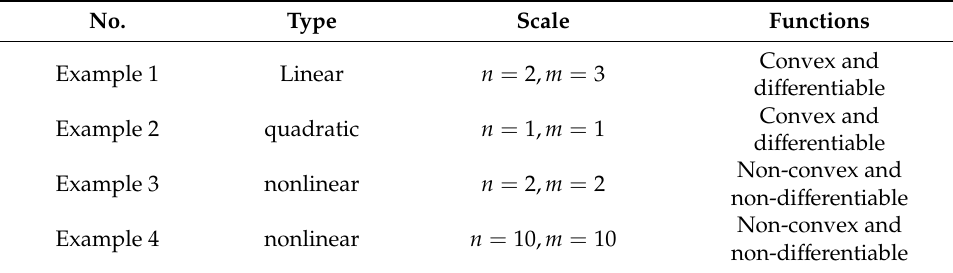
Table 1. The examples’